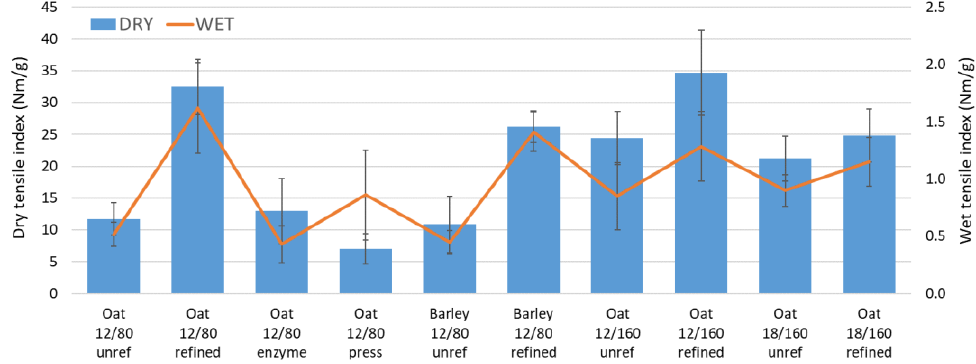
Figure 6. Dry and wet tensile indices of the straw sheets for varied preprocessing conditions. The hot-pressing time was 20 s for all other cases except the rightmost trial point, for which a long pressing of 30 min was applied.